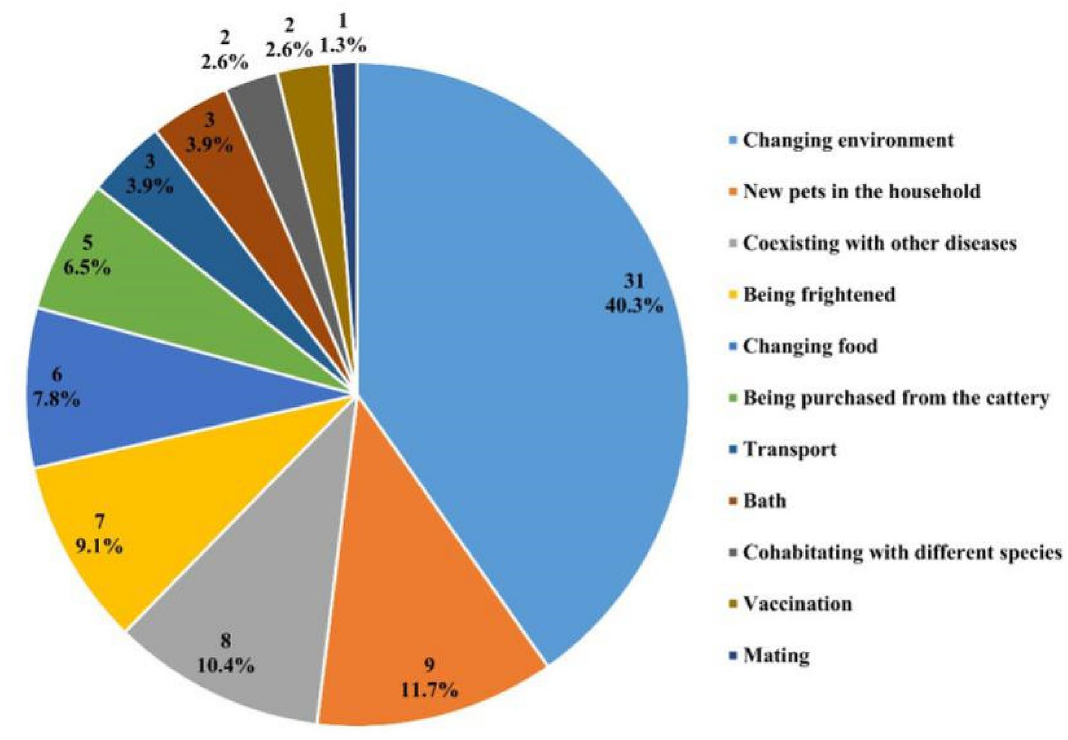
Figure 1. Frequency of documented stress situation of cats highly suspected of FIP.